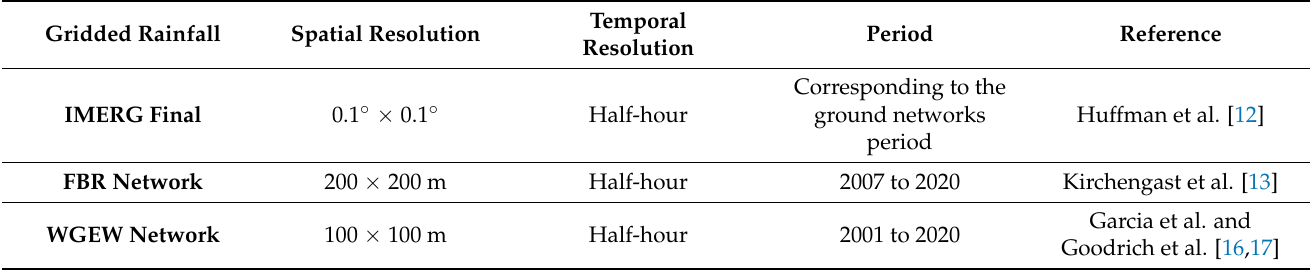
Table 1. Precipitation datasets used in this